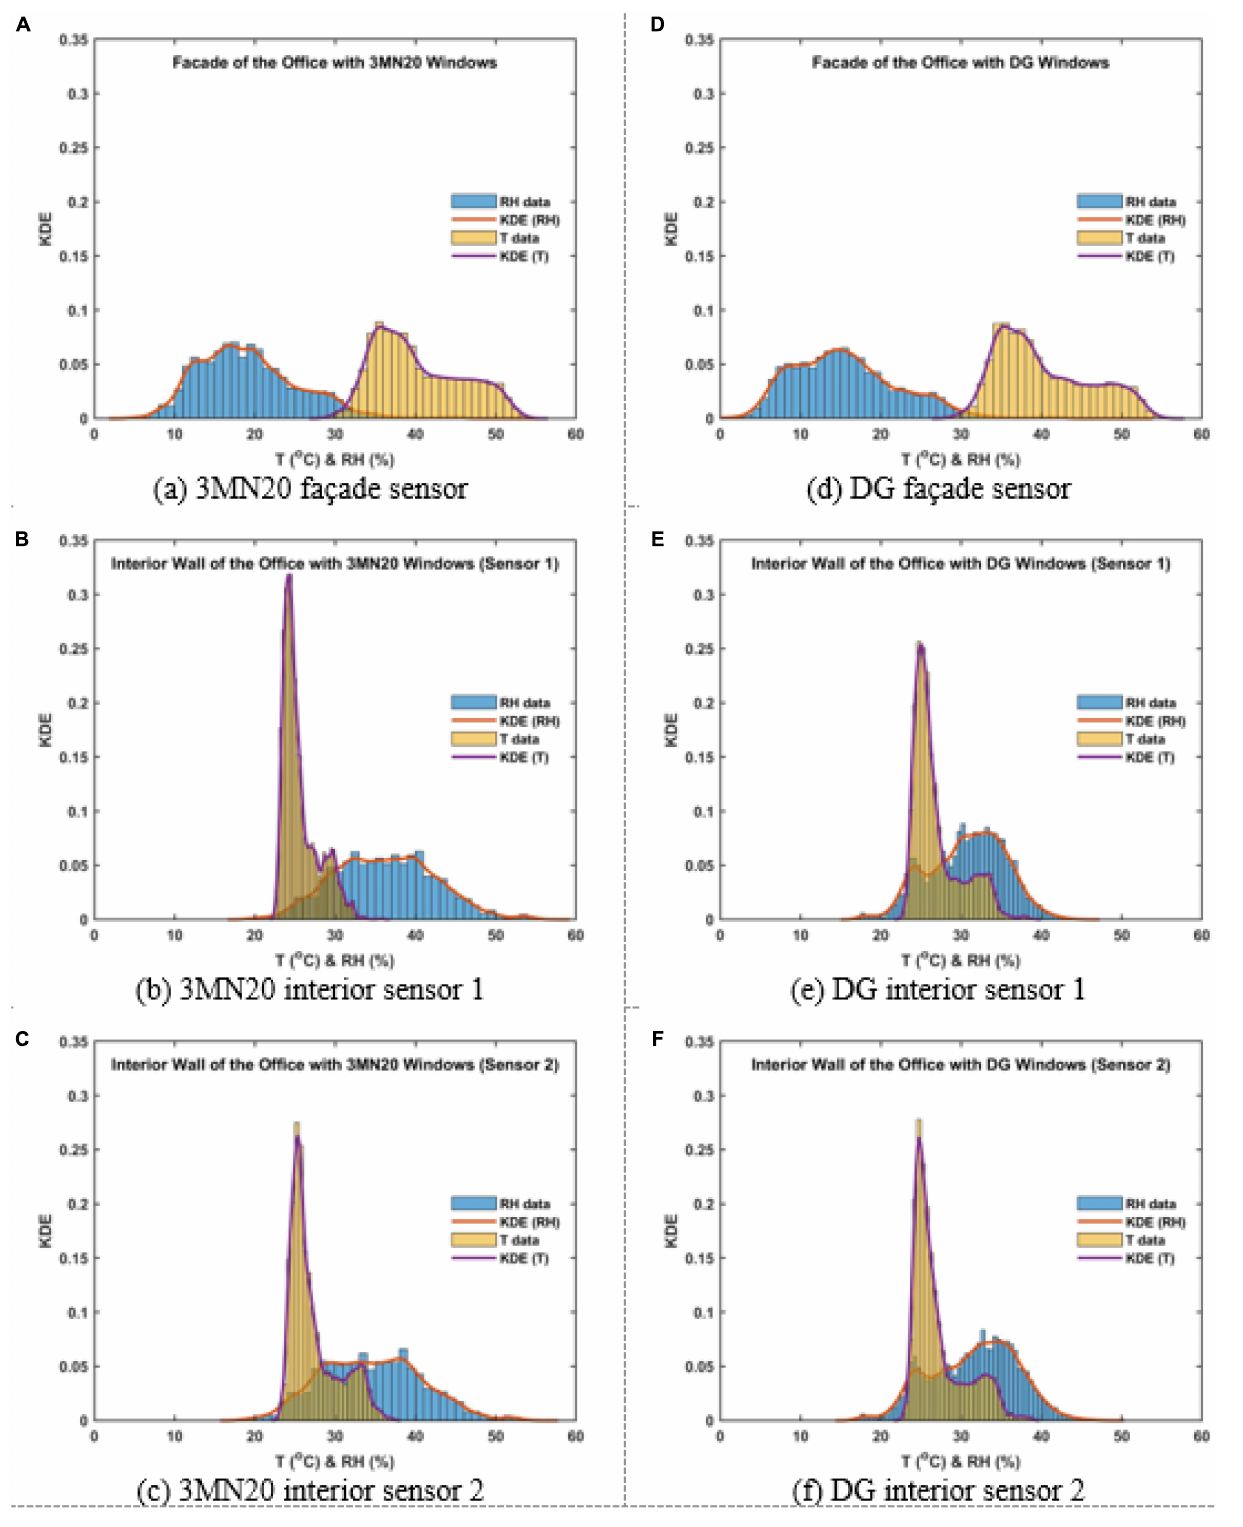
FIGURE 9 | Histograms and kernel density estimation (KDE) of temperature (T) and relative humidity (RH) for three DHT22 sensors on the façade and interior wall surface of offices during the month of June 2019; (A–C) 3MN20 windows, and (D–F) DG windows.